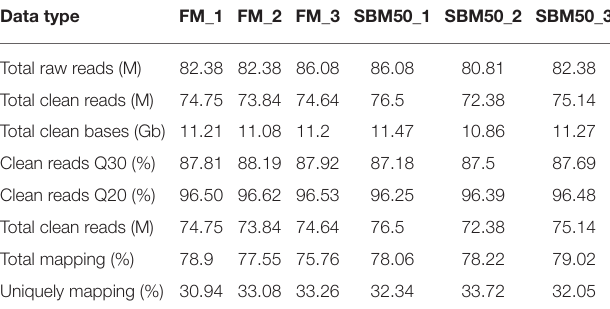
TABLE 3 | Overview of mRNA sequencing